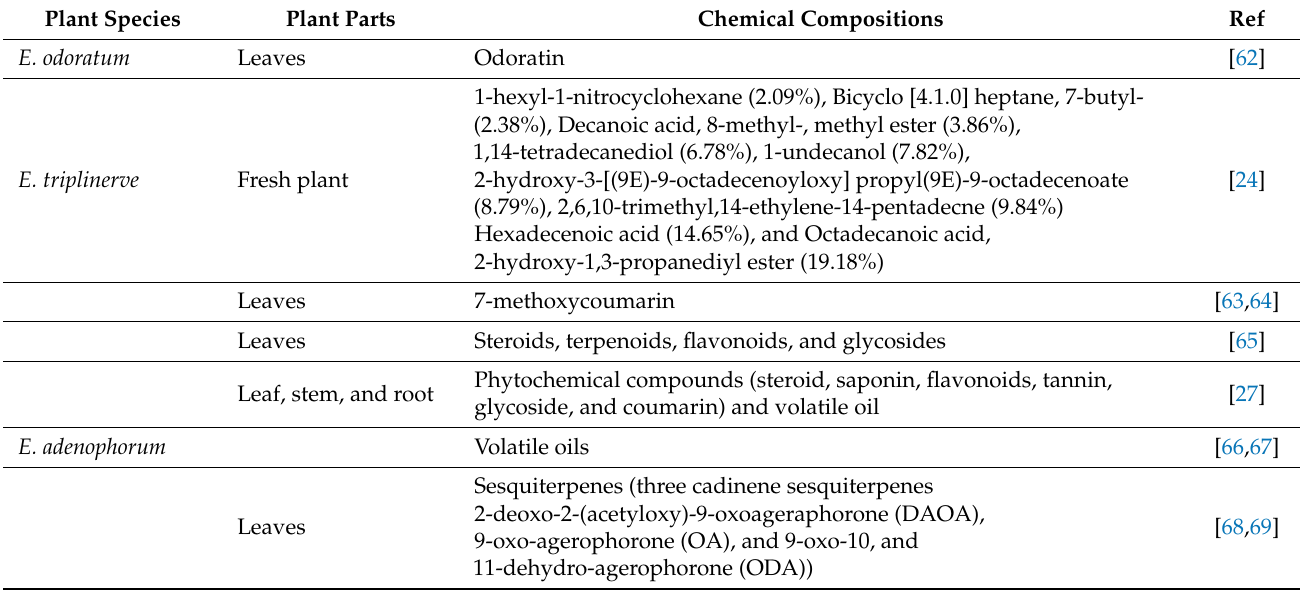
Table 1. Biochemical compounds of Eupatorium